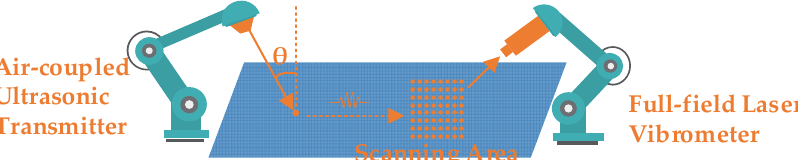
Figure 1. The air-coupled ultrasonic and full-field laser vibrometer detection system